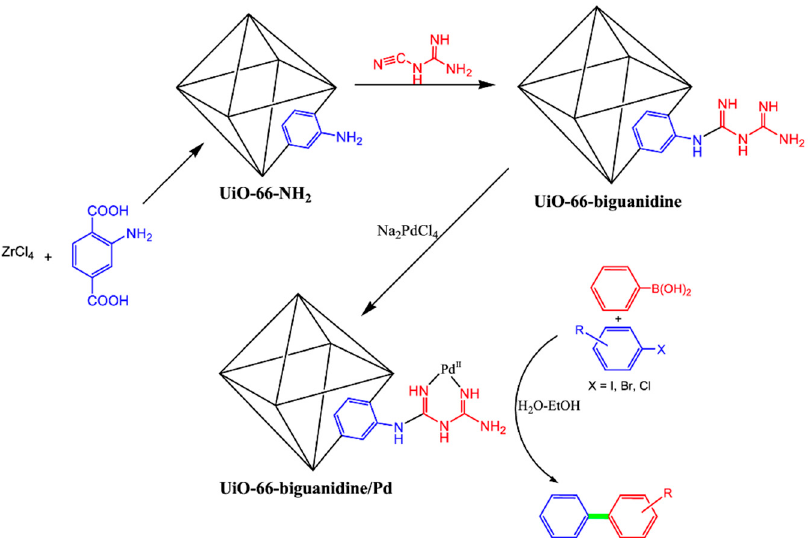
Figure 9. Sequential synthesis of UiO-66-biguanidine/Pd nanocomposite catalyst, adapted under a Creative Commons Attribution 4.0 License from [51] (p. 2) © 2021 Hojat Veisi, Mozhdeh Abrifam,